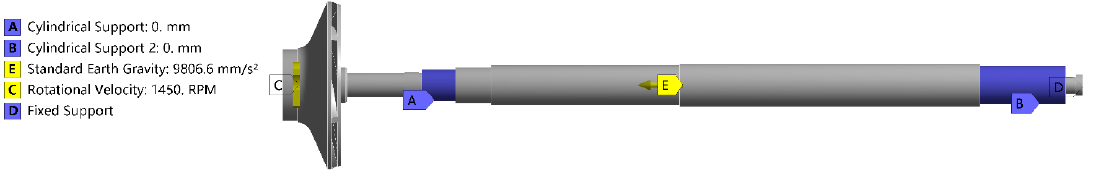
Figure 7. Constrained arrangement of rotor components.